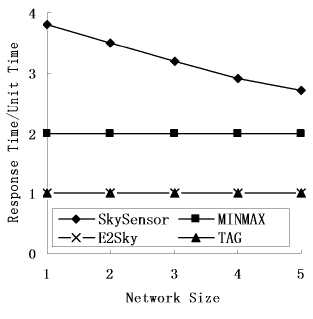
Figure 10. Response times under different network sizes. Sensors 2016 , 16 , 83